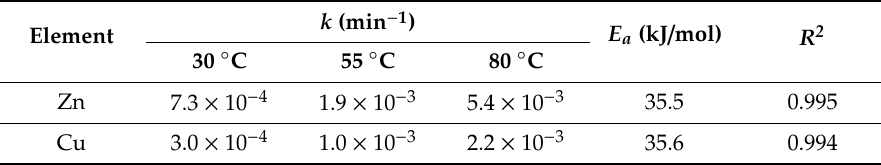
Table 6. Apparent rate constant ( k ) attained from fitting of experimental data using interface transfer and di ff usion model, which was used to obtain the activation energy ( E a ) using linear regression, including the coe ffi cient of correlation ( R 2